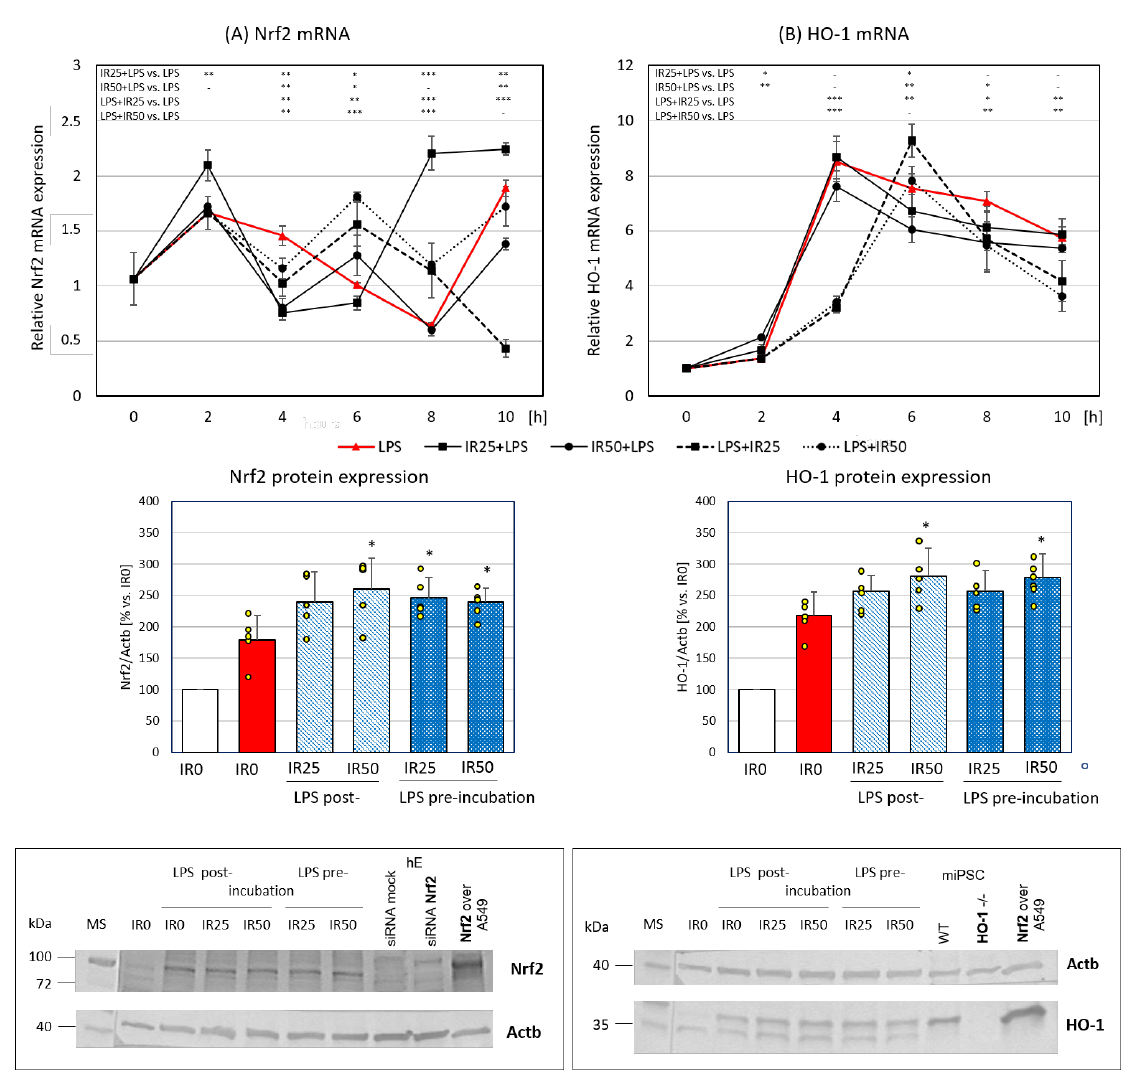
Figure 3. The time-course of nuclear factor erythroid 2-related factor 2 (Nrf2) and heme oxygenase-1 (HO-1) expression in RAW 264.7 macrophages after irisin (IR; 0, 25, or 50 nM) administered before or after LPS treatment: ( A ) kinetics of Nrf2 messenger RNA (mRNA) expression (upper panel) and Nrf2 protein expression 24 h after lipopolysaccharide (LPS; 100 ng/mL) stimulation (lower panel); ( B ) kinetics of HO-1 mRNA expression (upper panel) and HO-1 protein expression 24 h after LPS stimulation (lower panel); irisin was administered 2 h before (IR + LPS) or after LPS treatment (LPS + IR). Negative controls: siRNA mock and siRNA Nrf2 (hE: human endothelium; for Nrf2); HO-1 -/-: HO-1 gene knockout (miPSC: mouse induced pluripotent stem cells). Positive control: Nrf2 overexpression in A549 cells (Nrf2 over). Results are presented as the mean with standard deviation; n = 5. Statistically significant differences were calculated in relation to the IR0 + LPS group, used as a control group: * p < 0.05; ** p < 0.01; *** p < 0.001; “-“ not statistically significant. Actb: actin β; MS: mass standard; WT: wild type.